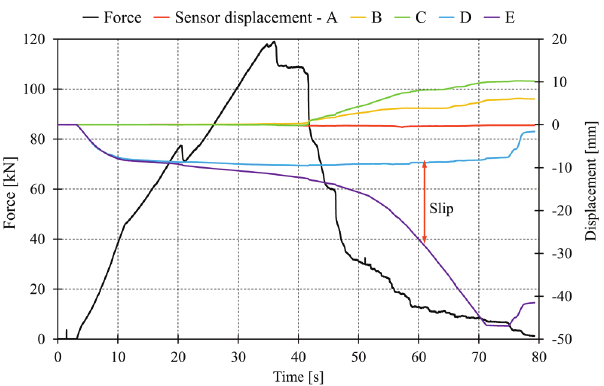
Fig. 10. Changes of displacements in a selected brick specimen